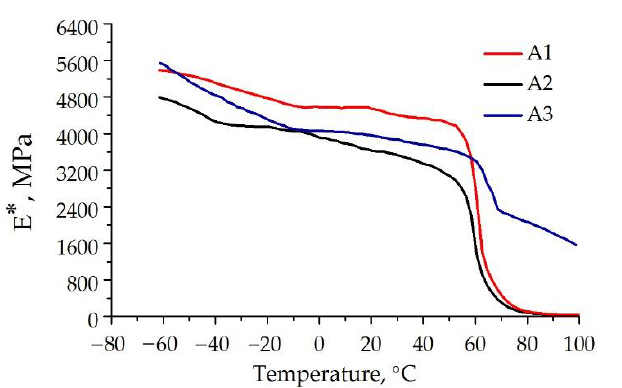
Figure 1. Effect of temperature on the behavior of E * for the materials of the epoxy compositions. The values of the glass transition temperature T g = 57 ◦ C for A1, 59 ◦ C for A2, and 62 ◦ C for A3 were determined according to ASTM D7028 at the points of intersection of the tangents to the curves of the temperature dependence of log E (cid:48) before and after the curve inflections. The arithmetic mean values of the complex modulus and its components determined from testing three specimens are shown in Table 2. Since the temperatures at which the adhesive joints were mechanically tested, − 50 and +23 ◦ C, were below the glass transition temperatures, the material of the adhesives was in the glassy state during testing, and it manifested practically no viscous properties; this is demonstrated by the small values of the loss modulus E (cid:48)(cid:48) and tan( δ